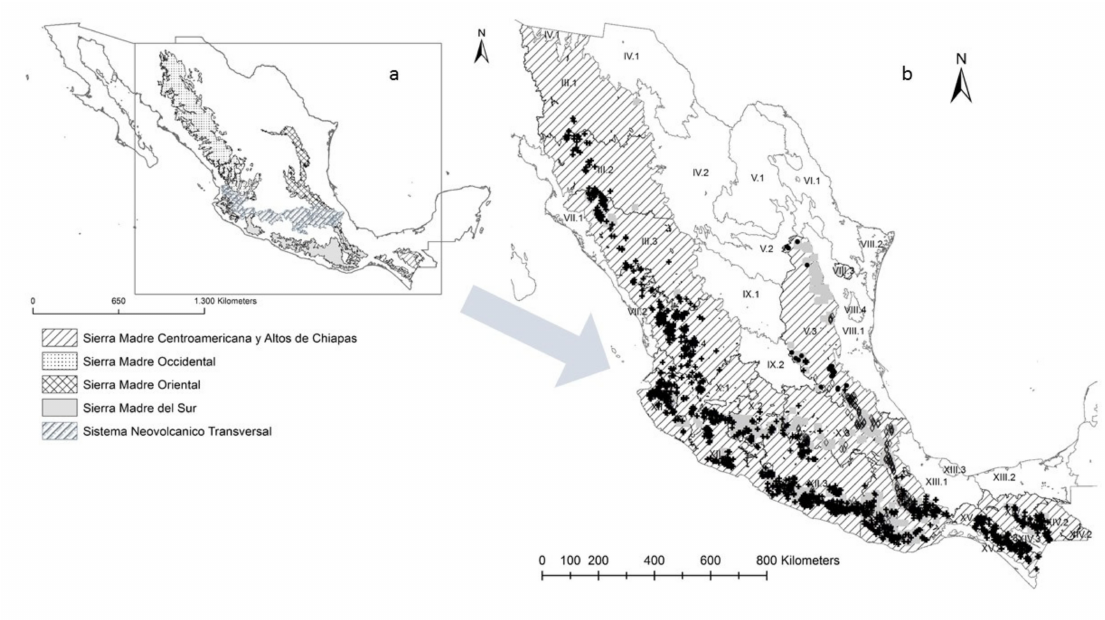
Figure 1. ( a ) Mexican territory with the five “sierras”. ( b ) Native distribution of Pinus greggi Engelm. ex Parl. (black dots), P. oocarpa Schiede ex Schltdl. (black crosses), P. patula Schiede ex Schltdl. & Cham. (unfilled diamonds) and P. pseudostrobus Lindl. (grey squares) in Mexico modified from the NFLI (see Material and Methods), and germplasm transfer zones (contour grey solid lines [29]. Striped germplasm transfer zones are indicative of the presence of at least one of the four pine